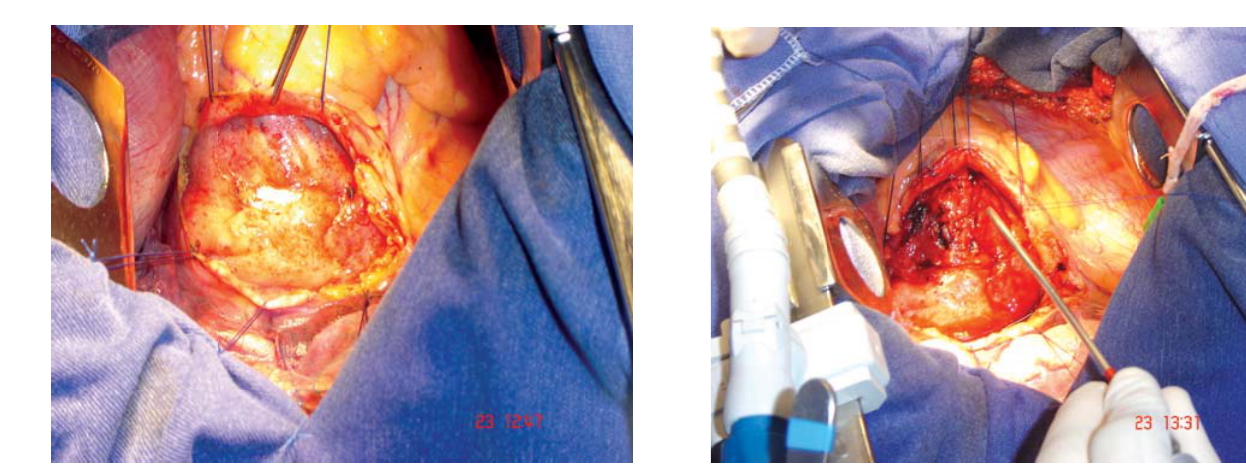
Fig. 1 - Aspecto da exposição da face póstero-lateral do ventrículo Fig. 2 - Ramo marginal da artéria circunflexa rodeado com fios